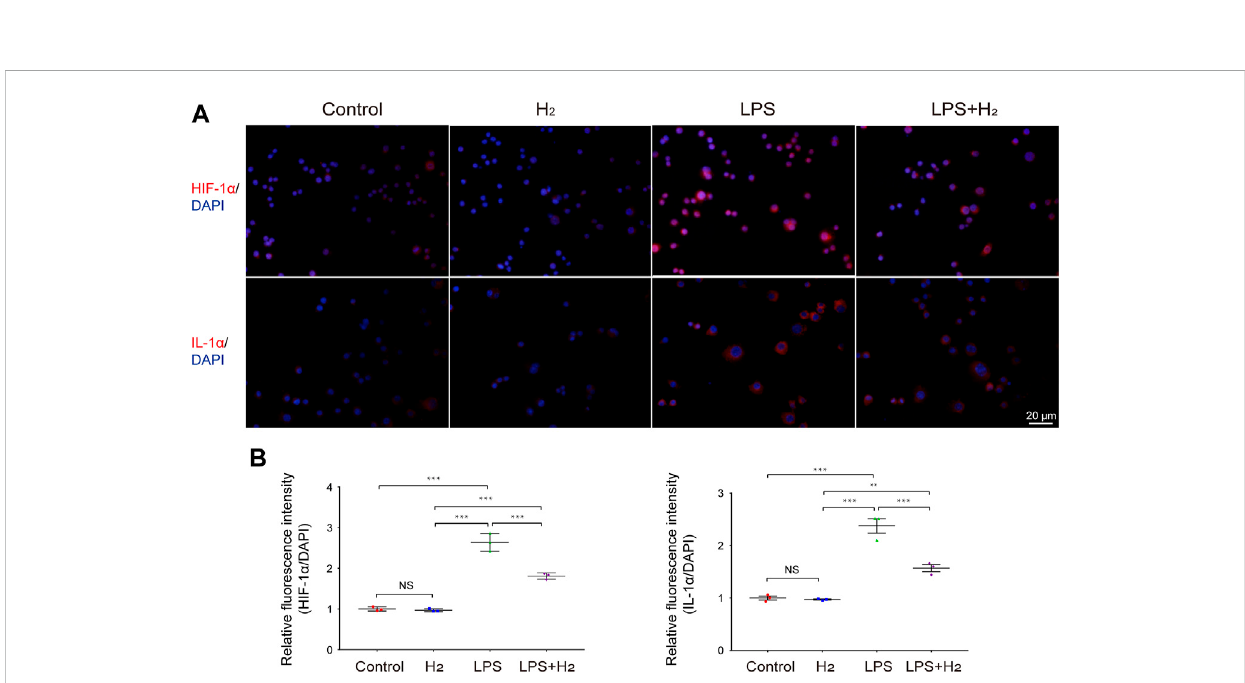
FIGURE 4 Effects of hydrogen on LPS-induced HIF-1 α , and IL-1 α expression in RAW264.7 cells. (A) Representative images of HIF-1 α and IL-1 α activation in RAW264.7cells in response to 1 μ g/mL LPS and/or 60%hydrogen treatments for 0.5 h. Scale bar, 20 μ m. (B) The HIF-1 α , and IL-1 α immuno fl uorescence was quantitated and presented as relative fl uorescence intensity (mean ± SEM; ** p < 0.01; *** p < 0.001; not signi fi cant (NS), p > 0.05; n =